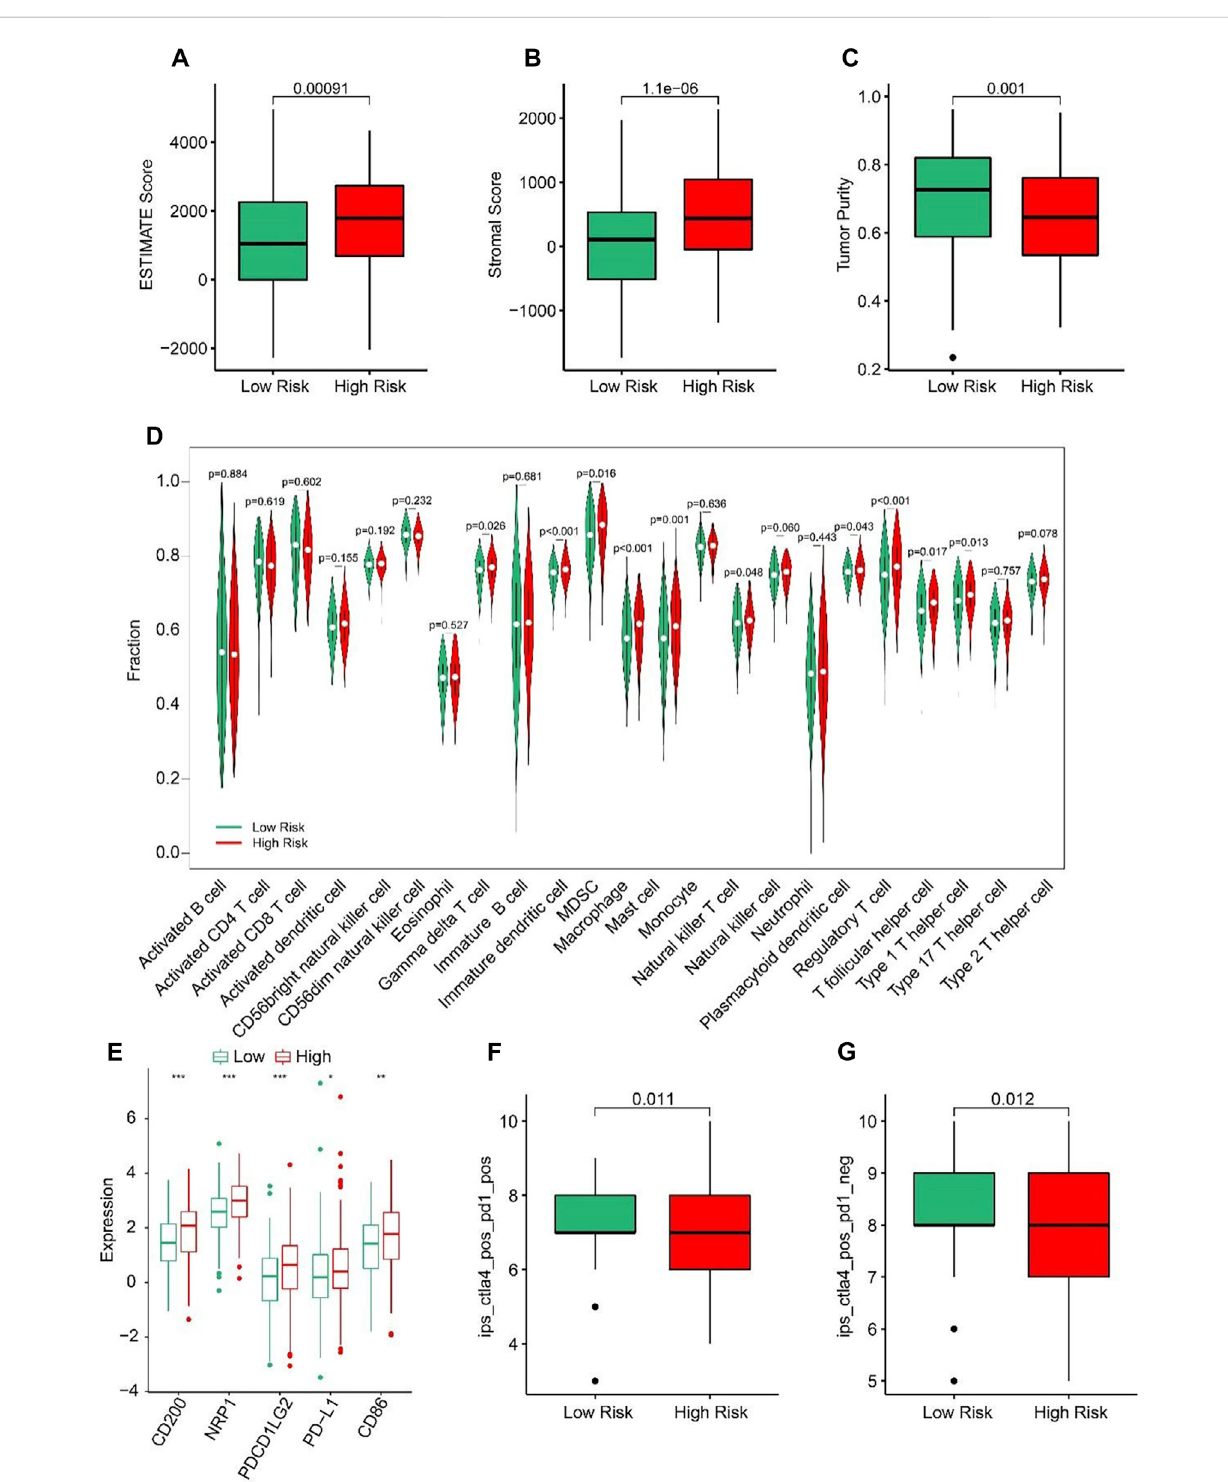
FIGURE 7 Immune in fi ltration landscape of patients in the low- and high-risk group. (A) ESTIMATE score. (B) Stromal score. (C) Tumor purity. (D) The proportion of 23-type cells of patients in low- and high-risk groups. (E) The expression of immune checkpoint inhibitor in the low- and high-risk groups. (F, G) Immunophenoscore (IPS) * p < 0.05, ** p < 0.01, *** p <